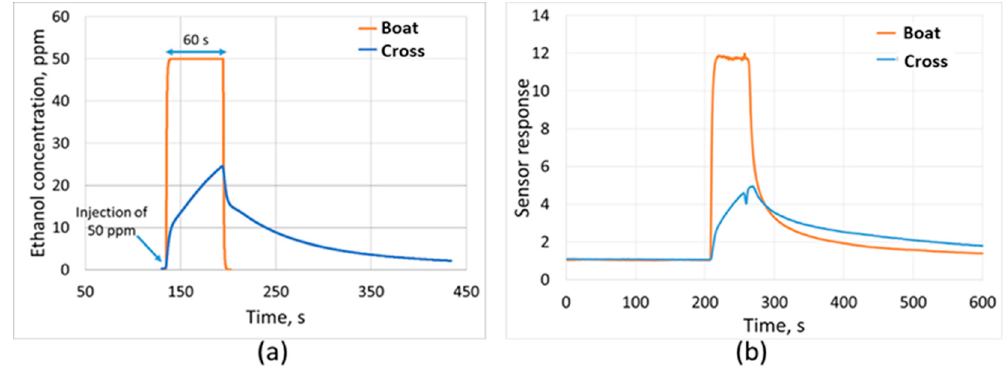
Figure 2. ( a ) Simulation results of gas concentration convection/diffusion in both chambers; ( b ) Experimental sensor response toward 50 ppm of ethanol for both chambers.